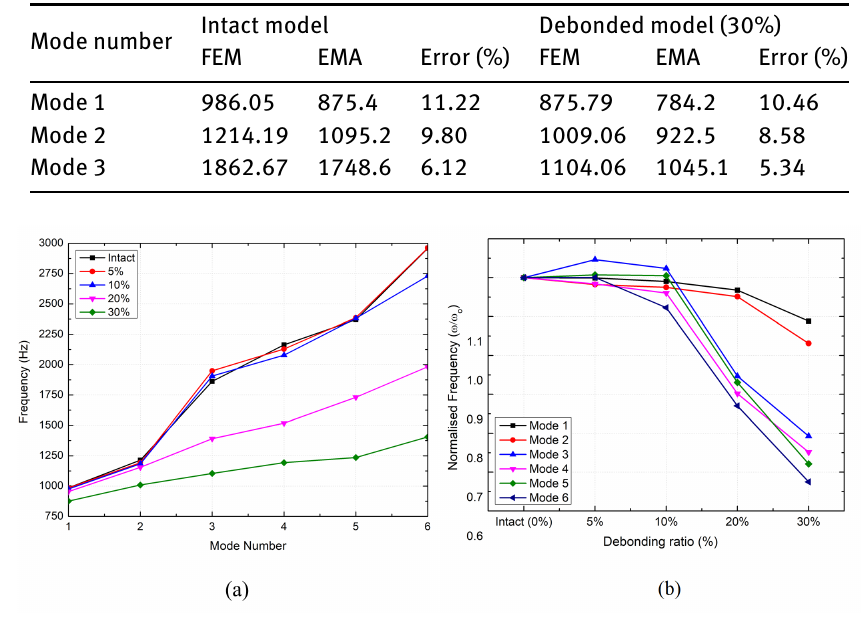
Figure 6: Comparison of a) natural frequency b) normalised natural frequency between intact and debonded